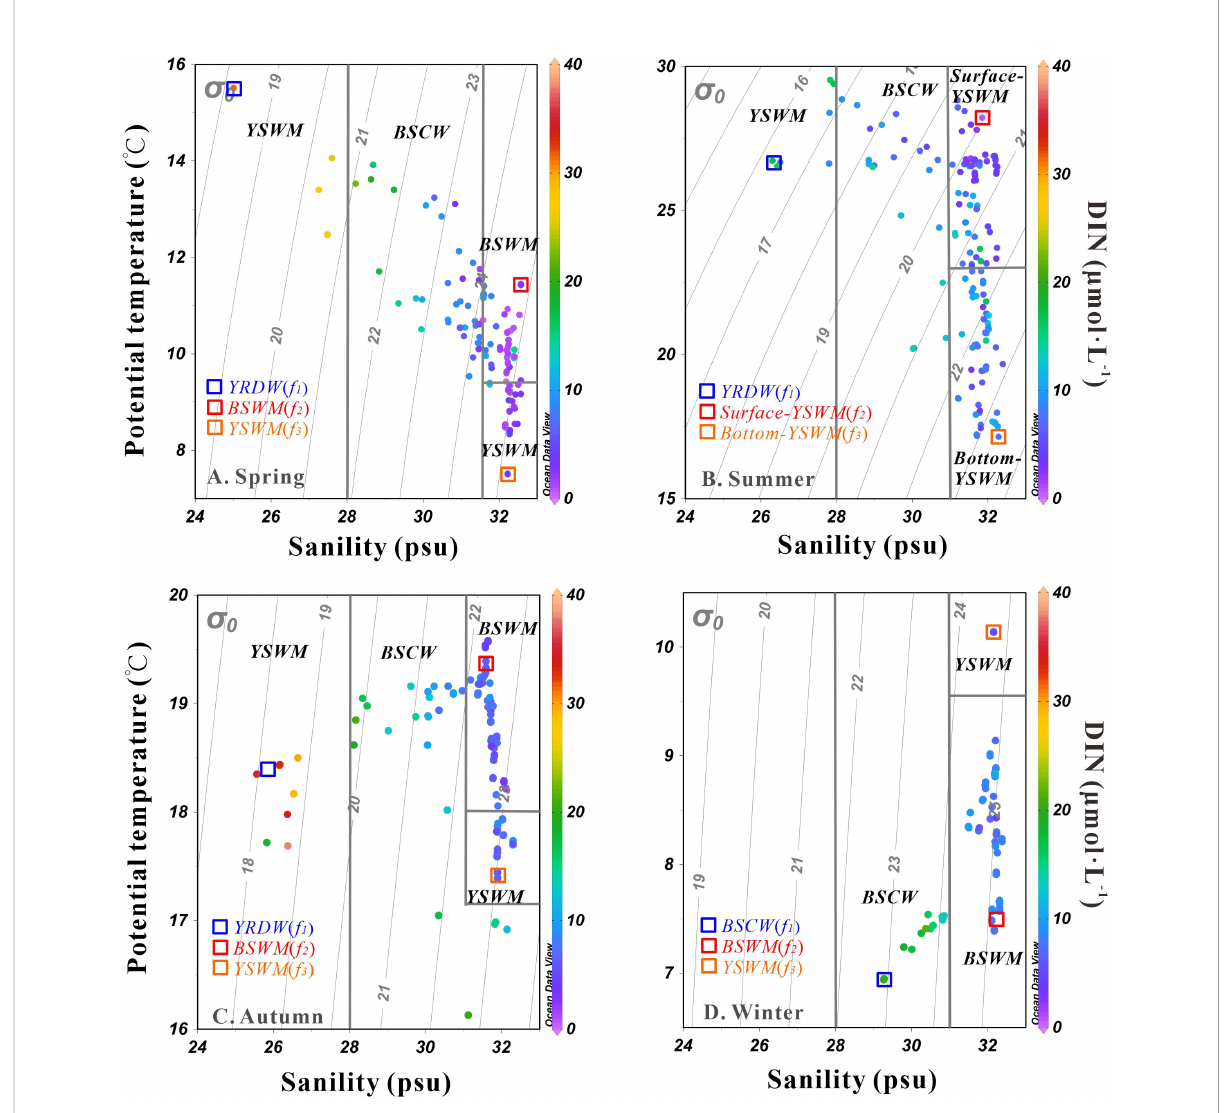
FIGURE 6 The potential temperature ( q ) vs . salinity scheme in the Bohai Sea in spring (A) , summer (B) , autumn (C) and winter (D) , with the color of solid dots representing DIN concentration. End-members are marked with different colored